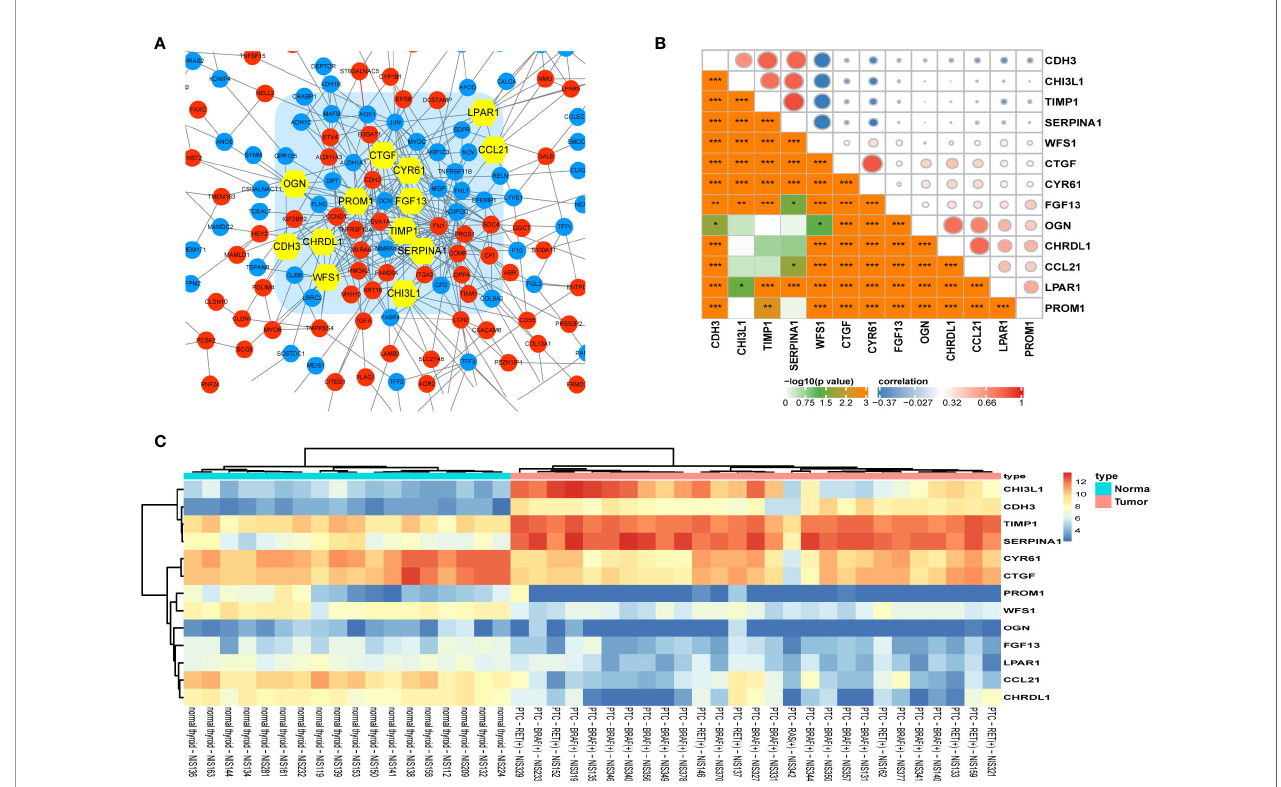
FIGURE 5 | Identi fi cation and analysis of hub genes. (A) Thirteen statistically signi fi cant hub genes were screened using the Cytoscape software plugin cytoHubba. (B) Pearson ’ s correlation analysis of 13 hub genes. (C) The hierarchical clustering heat map of the 13 most signi fi cant hub genes was constructed using the GSE58545 dataset. Orange indicates that the expression of genes is relatively upregulated, blue indicates that the expression of genes is relatively downregulated. (*p< 0.05; **p < 0.01; ***p < 0.001).